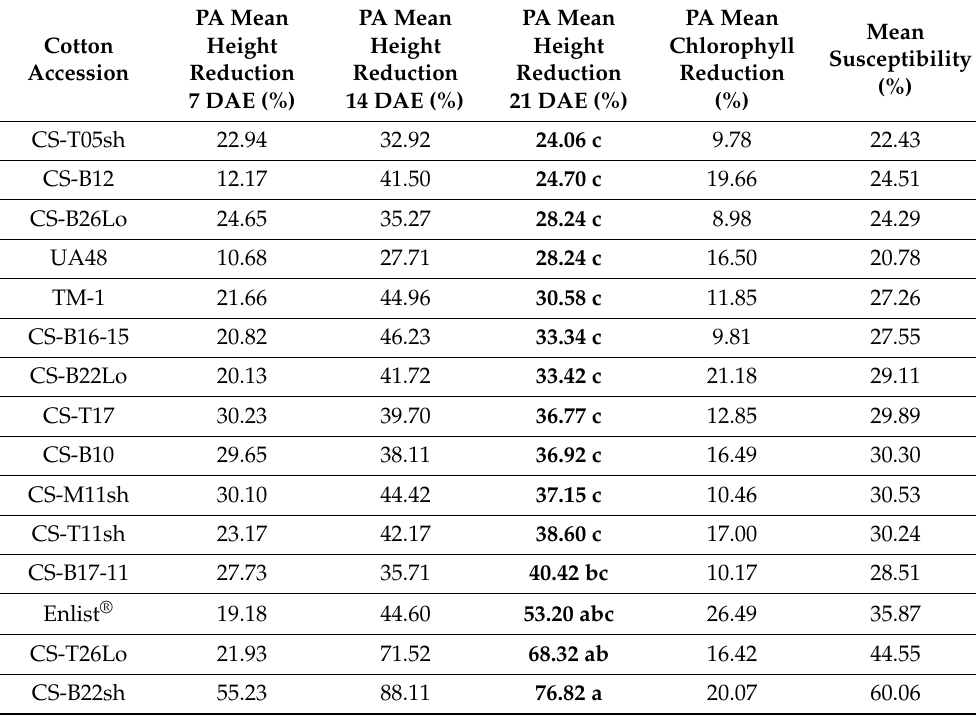
Table 1. Palmer amaranth (PA) height and chlorophyll reduction values in the presence of cotton chromosome substitution (CS)